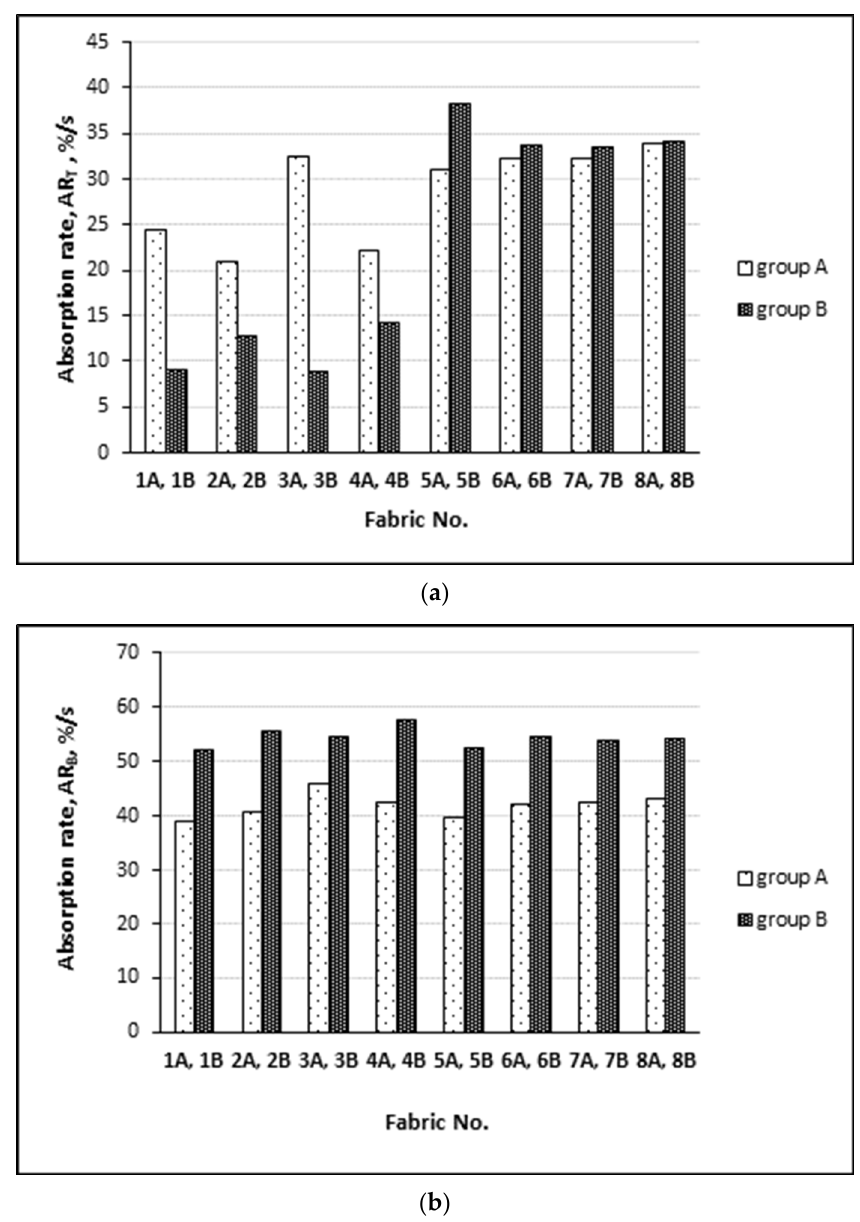
Figure 5. Absorption rate of the knitted fabrics investigated on: ( a ) the inner surface of the fabrics; ( b ) the outer surface of the fabrics.